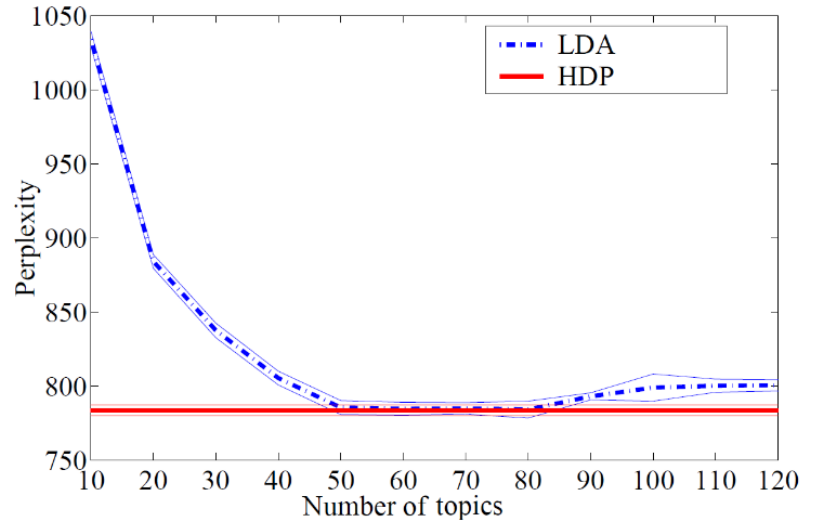
Figure 11. Topic models’ coherence scores for SIGIR dataset at K = 20.